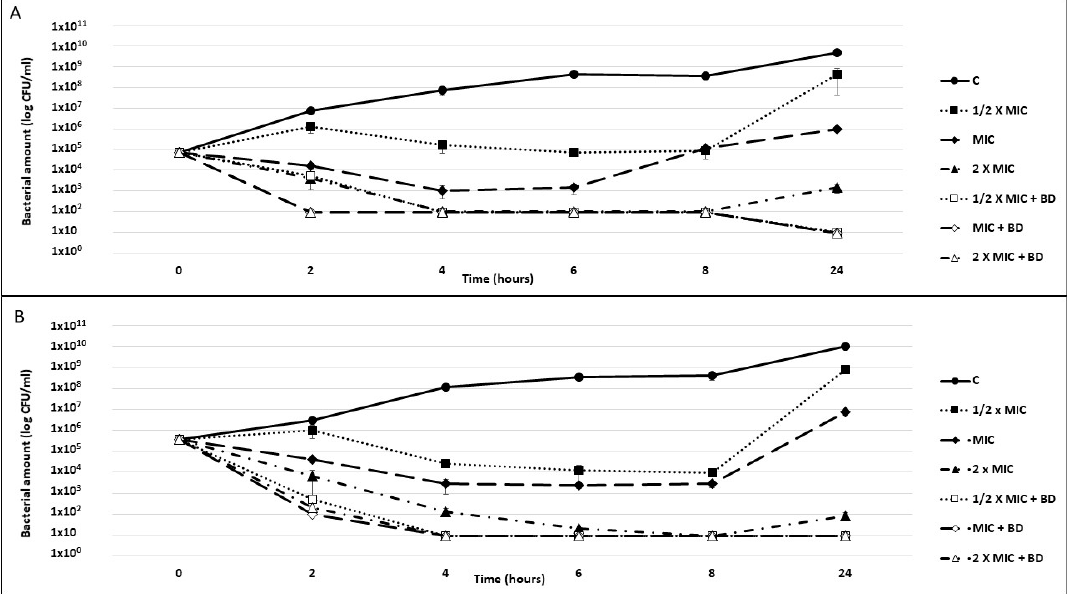
Figure 5. P. aeruginosa killing curves. Exponential phase cultures of P. aeruginosa PA7 were challenged for 24 h with tobramycin at concentrations corresponding to 1/2× the MIC, the MIC, and 2× the MIC, alone or combined with 40 µg/mL o-CH 3 ( A ) or 320 µg/mL p-CH 3 ( B ) berberine derivatives (BDs). A culture exposed neither to antibiotics nor to compounds was used as a growth control (C). The reported results are the average of two replicates ± standard deviation.